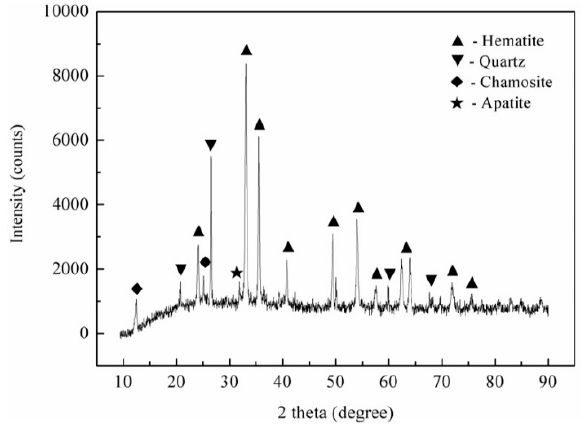
Figure 1. X-ray diffraction pattern of the ore sample. Figure 1. X ‐ ray diffraction pattern of the ore sample. Figure 1. X ‐ ray diffraction pattern of the ore sample.